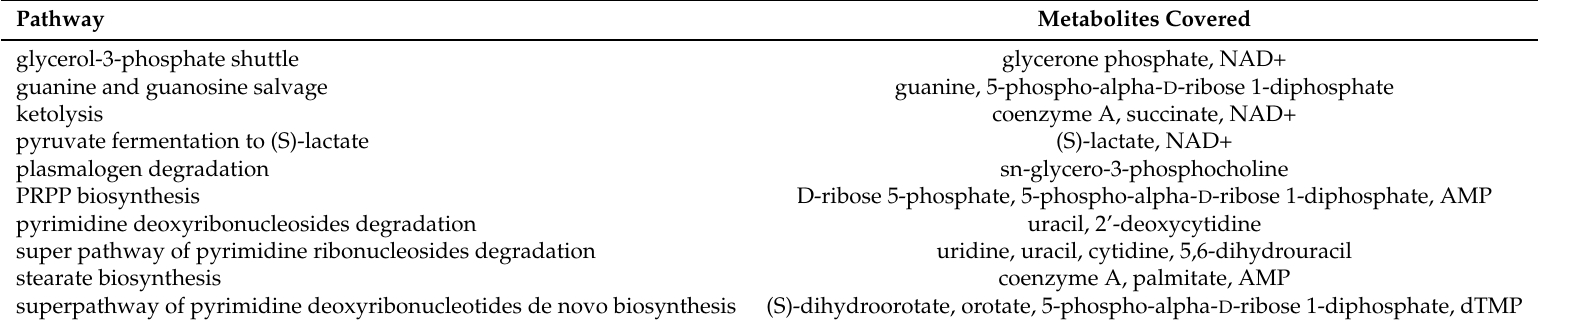
Table A13. McDonnel 2013, Pathway Covering Using Covered Compound Sparseness Cost Function.